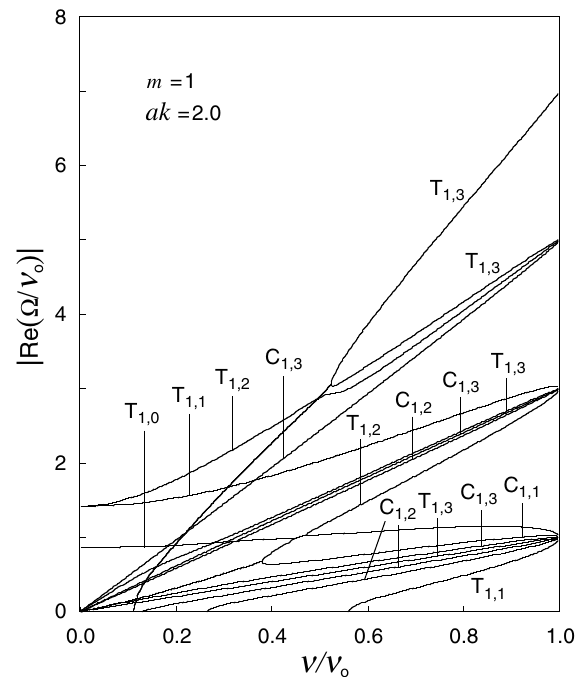
FIG. 2. Absolute value of the real part of (cid:13) =(cid:10) dipole modes as a function of (cid:10)=(cid:10) and zero wall impedance ( Z (cid:3) 0 ).